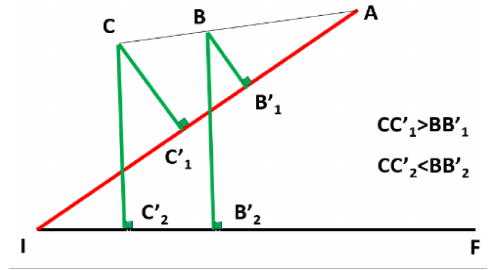
Figure 7. Relative and absolute PIPs (source: own processing)